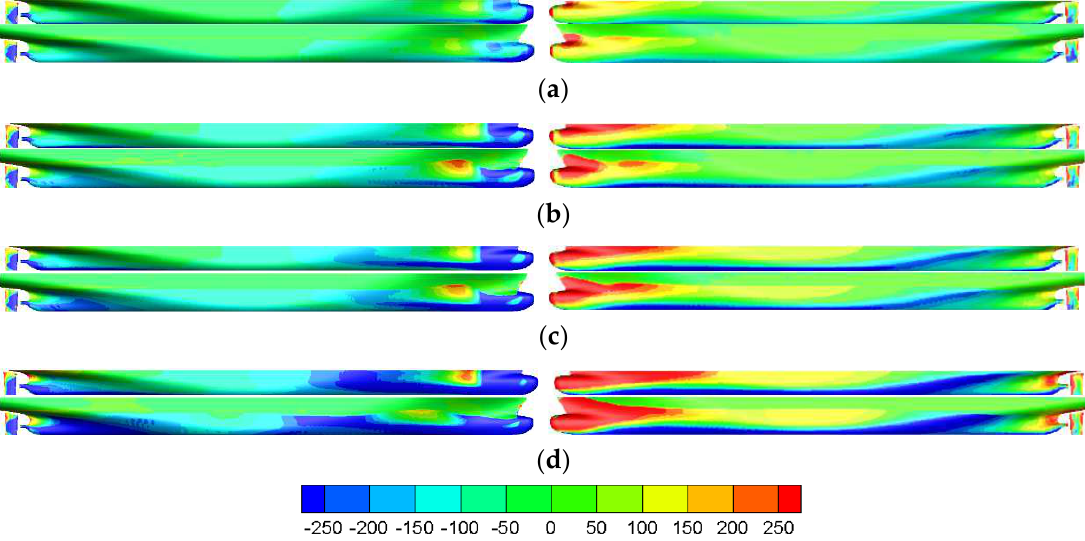
' (cid:48) X . ( b ): Y (cid:48) . ( c ): N (cid:48) . H + R + . ( b ): H R